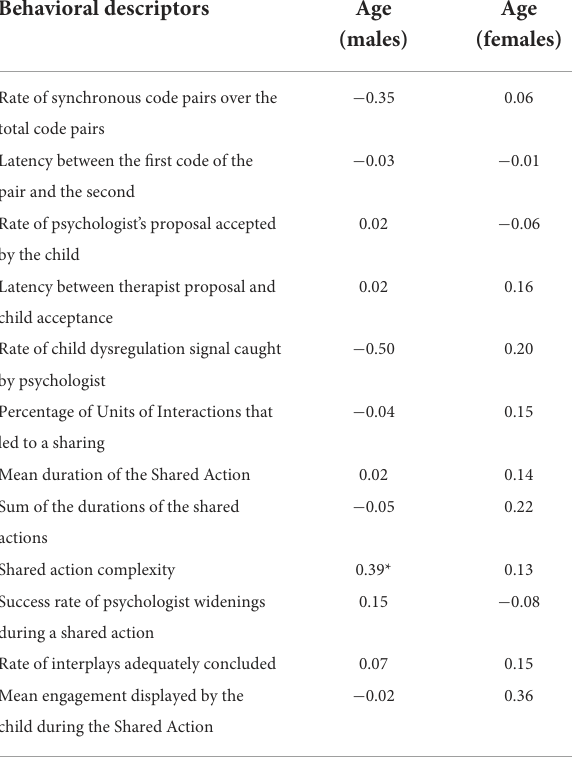
TABLE 3 Correlations among behavioral descriptors and age in male and female